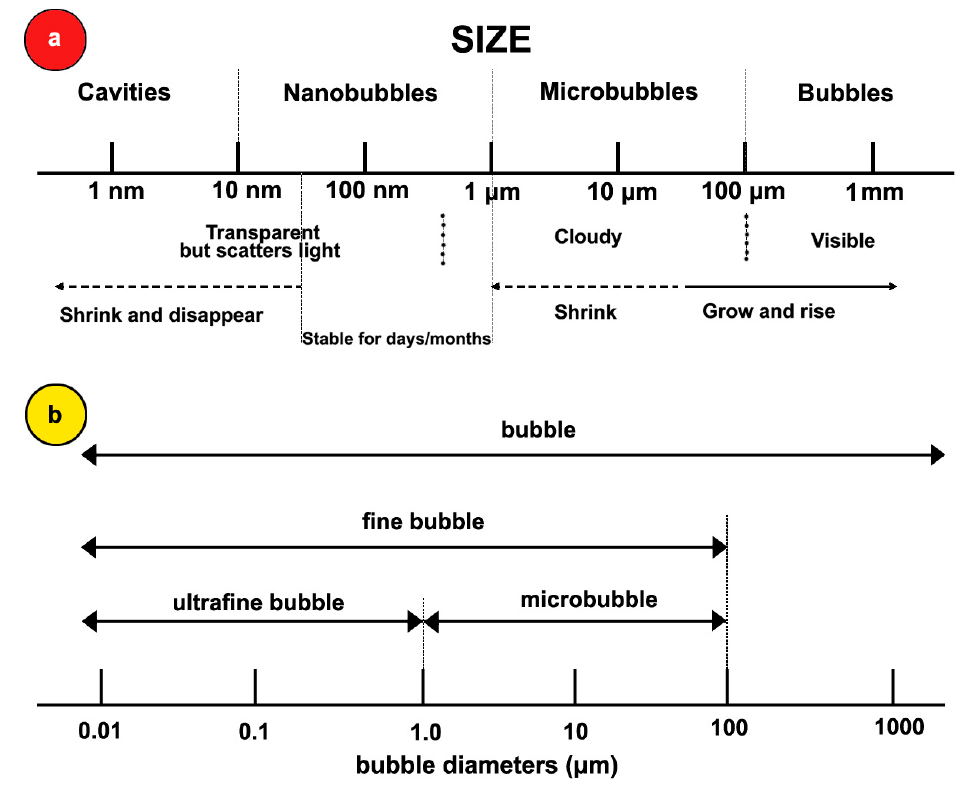
Figure 1. ( a ) The spectrum of bubble sizes according to their stability. ( b ) Bubble diameter classification according to ISO 20480-1-2017 [9].